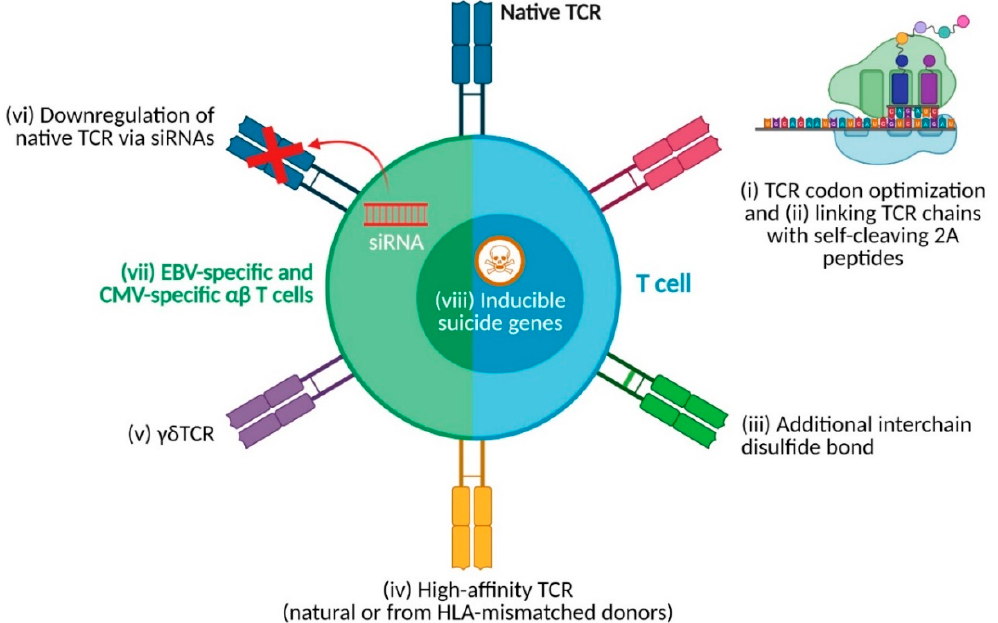
Figure 2. TCR-directed optimization strategies that have been clinically tested in AML. Different strategies to enhance TCR-T-cell therapies have been used in clinical trials for the treatment of AML. These include (i) codon optimization of transgenic TCR sequences to improve protein translation; (ii) linking transgenic TCR alpha and beta chains via self-cleaving 2A peptides for equimolar expression of TCR chains; (iii) addition of cysteine residues that bind covalently to provide a second interchain disulfide bond and improve pairing of transgenic TCR chains; (iv) usage of high-affinity TCRs, either derived from normal TCR repertoires after screening of multiple TCR candidates or from HLA-mismatched donors to generate allo-restricted TCRs, to enhance antigen recognition; (v) TCR-engineering with γδ TCRs derived from γδ T cell clones, or (vi) downregulation of native TCR chains via introduction of small interfering “silencing” RNAs (siRNAs) targeting native TCR transcripts to prevent TCR mispairing; (vii) usage of autologous donor-derived Epstein–Barr virus (EBV) and cytomegalovirus (CMV)-specific T cells to prevent EBV and CMV infections and graft-versus-host disease in TCR-T-cell treated patients; and (viii) introduction of inducible suicide genes that would allow the elimination of TCR-engineered T cells in case of treatment-related toxicities. Created with